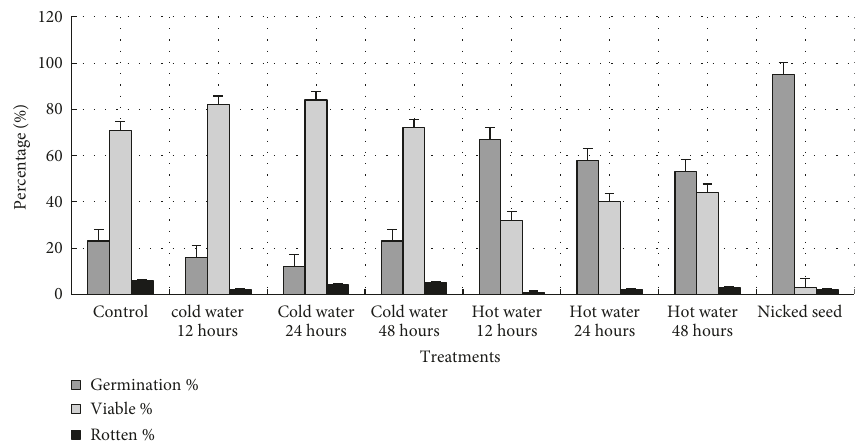
Figure 2: Germination and viability (cutting) test of Senna spectabilis , 28 days after seed sowing.